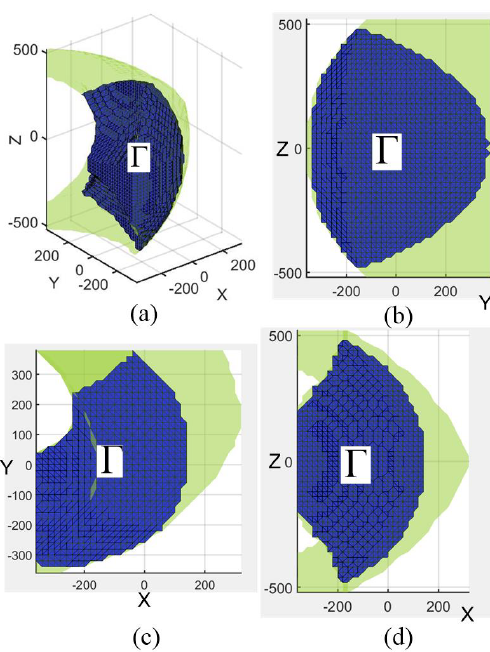
Figure 20. Efficient workspace (cid:48) of the optimized configuration: (a) oblique view, (b) front view, (c) top view, (d) side view.